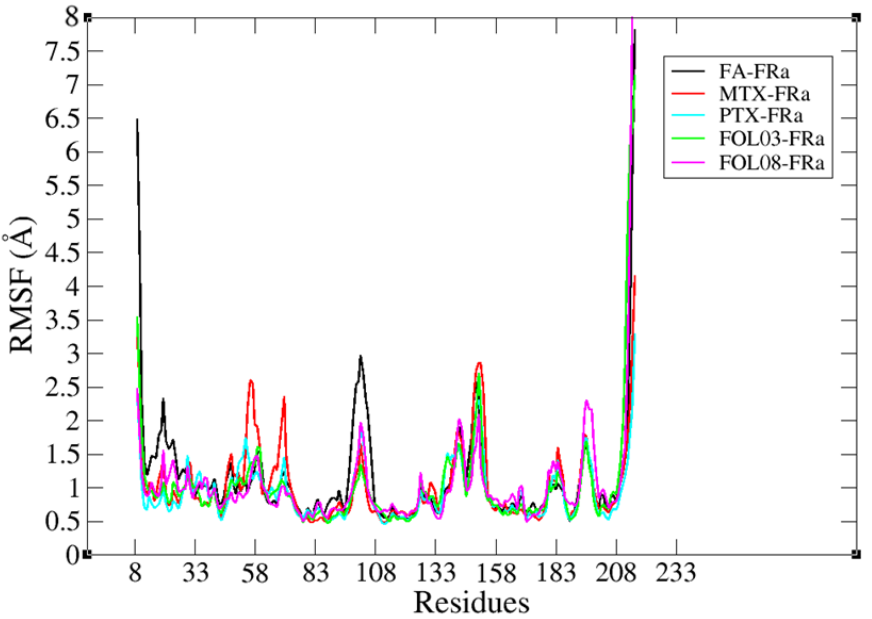
Figure 12. Root mean square fluctuation (RMSF) diagram results for complexes FA (black), MTX (red), PTX (cyan), FOL03 (green), and FOL08 (magenta).